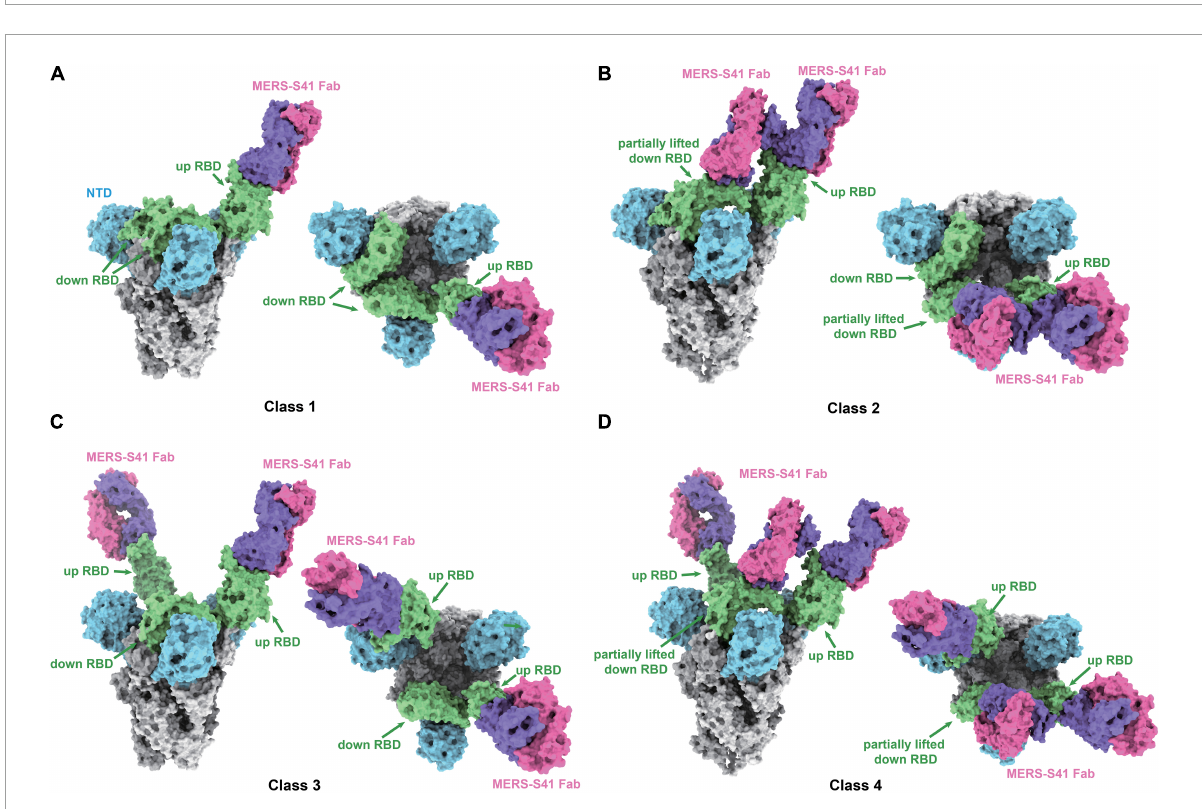
FIGURE2 Cryo-EM structures of the MERS-S41 Fab bound to MERS-CoV spike trimer. (A) Class 1 shows MERS-S41 Fab bound to one “up” RBD. (B) Class 2 shows one “up” RBD bound by two MERS-S41 Fabs. (C) Class 3 shows two “up” RBDs bound by two MERS-S41 Fabs. (D) Class 4 shows two “up” RBDs bound by three MERS-S41 Fabs. In panels (A–D) , the MERS-CoV spike trimer NTDs are colored in blue, RBDs in green and other domains in gray. The light chain and heavy chain of MERS-S41 are colored in magenta and purple. The representations are models, shown as surface using Chimera